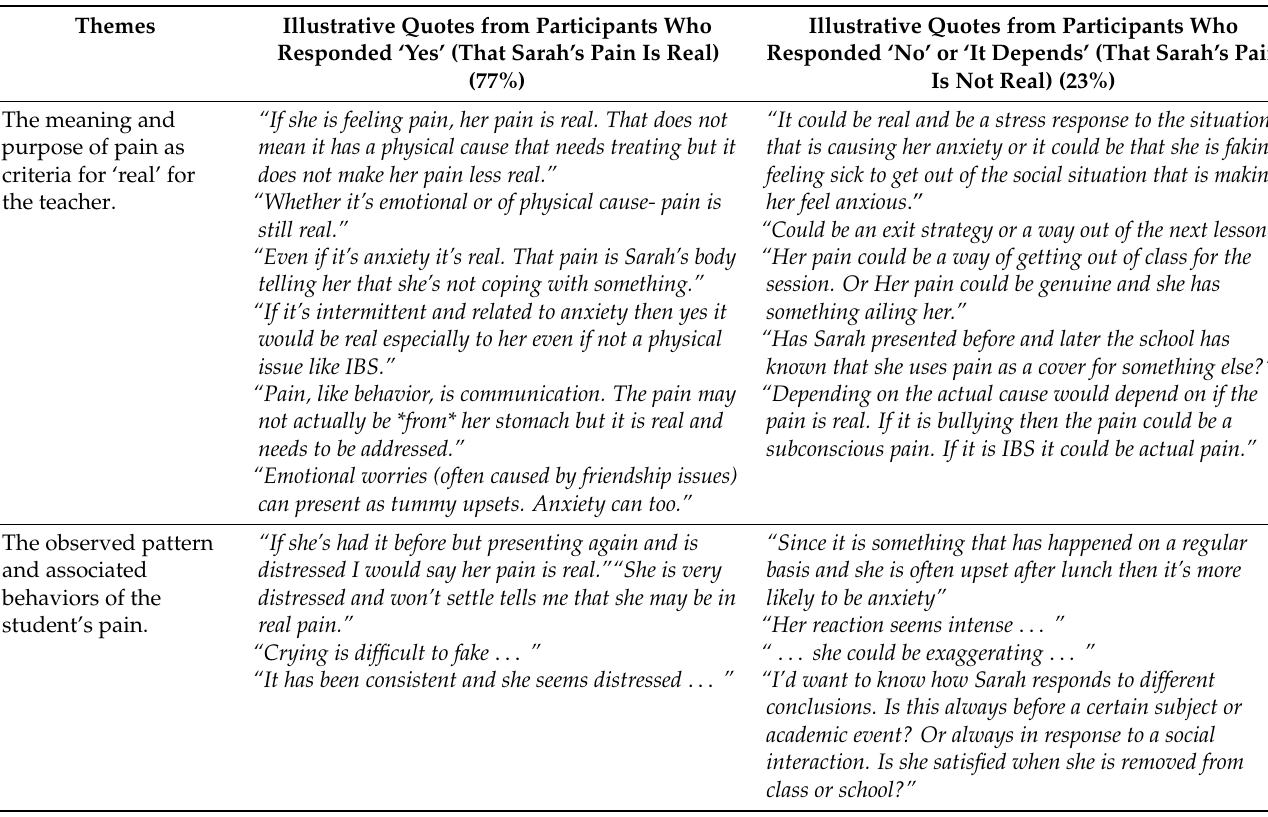
Table 3. Quotations to illustrate the themes from the responses to: ‘Please tell us more about why